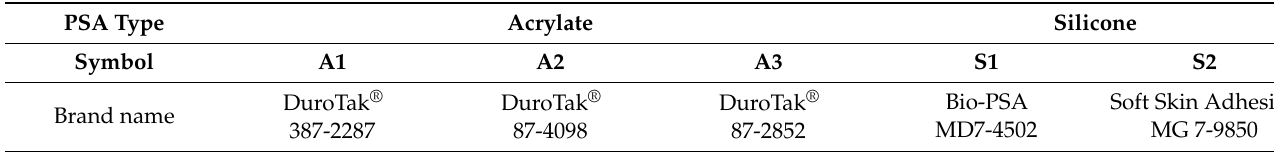
Table 1. Characteristics of the commercial polymers used for the preparation of adhesive matrices [14–16].